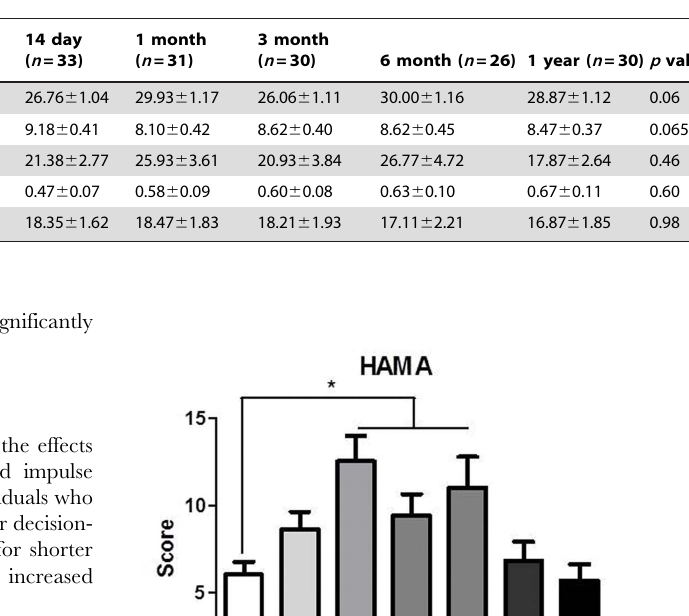
Table 1. Demographic characteristics of subjects.